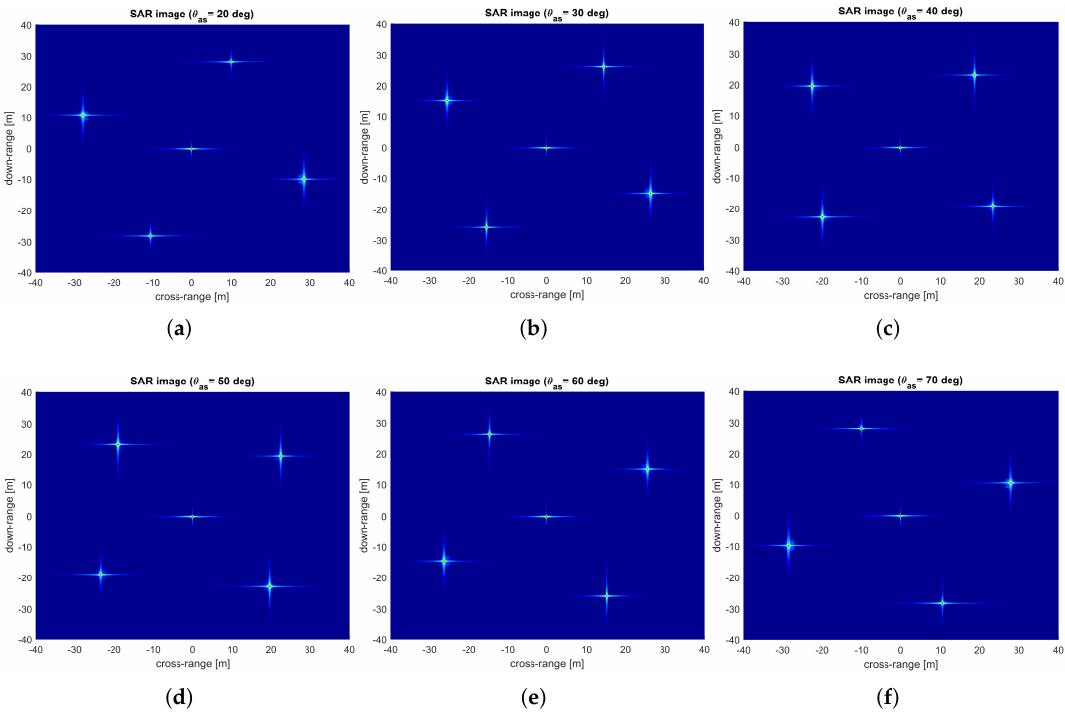
Figure 21. SAR video frames before image rotation at aspect angle: ( a ) 20°; ( b ) 30°; ( c ) 40°; ( d ) 50°; ( e ) 60°; ( f )